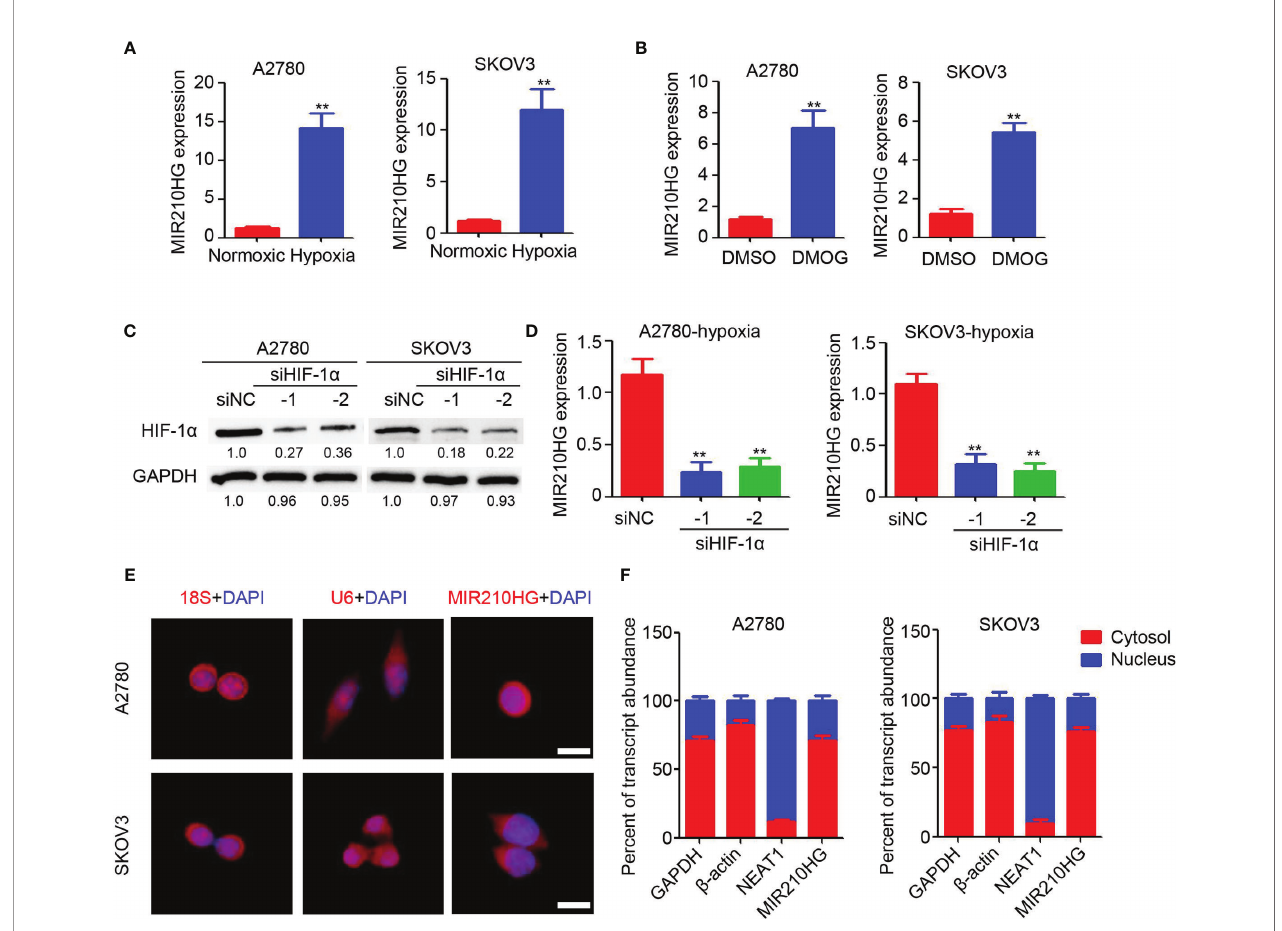
FIGURE 1 | Hypoxia induced lncRNA-MIR210HG in ovarian cancer. (A) qPCR analysis of lncRNA-MIR210HG expression in A2780 and SKOV3 cells treated with normoxic and hypoxia condition for 48 hours (n = 3, **p < 0.01). (B) qPCR analysis of lncRNA-MIR210HG expression in A2780 and SKOV3 cells treated with DMSO or DMOG for 48 hours (n = 3, **p < 0.01). (C) Western blotting detection of HIF-1 a expression in A2780 and SKOV3 cells transfected with siRNA targeting HIF-1 a and negative control under hypoxia condition. GAPDH was used as a loading control. (D) qPCR analysis of lncRNA-MIR210HG expression in A2780 and SKOV3 cells transfected with siRNA targeting HIF-1 a and negative control under hypoxia condition (n = 3, **p < 0.01). (E) Detection of lncRNA-MIR210HG, U6 and 18S in A2780 and SKOV3 cells by FISH staining under hypoxia condition. Cell nucleus was stained by DAPI. Scale bar = 10 m m. (F) qPCR analysis of lncRNA-MIR210HG, GAPDH, NEAT1 and b -actin expression in nucleus and cytosol of A2780 and SKOV3 cells under hypoxia